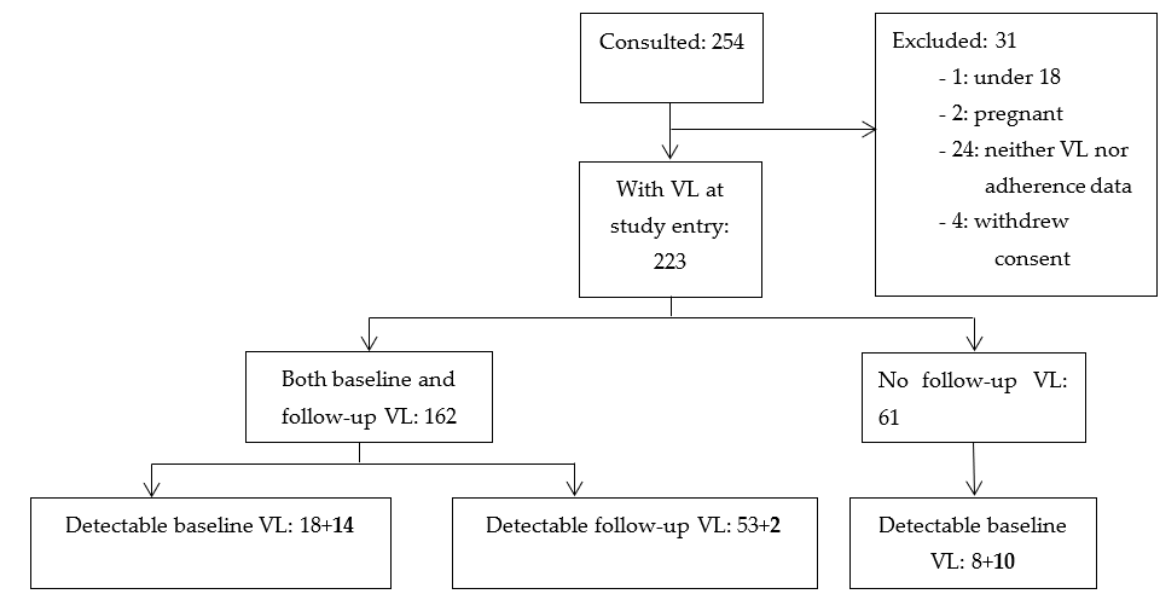
Figure 1. Patient sampling flowchart. Starts from patients invited to participate in the study cohort. A total of 105 patients with detectable viral load (VL) are shown in the boxes at the bottom. In bold is the number of patients who started therapy at study entry, and the others were already cART-experienced patients.